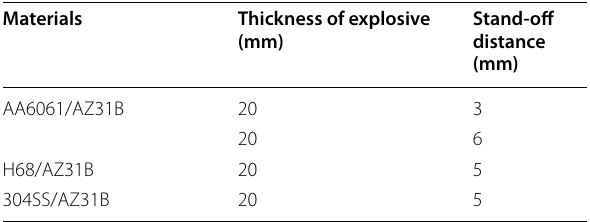
Table 1 Welding parameters of the bimetal combinations used in the experiments